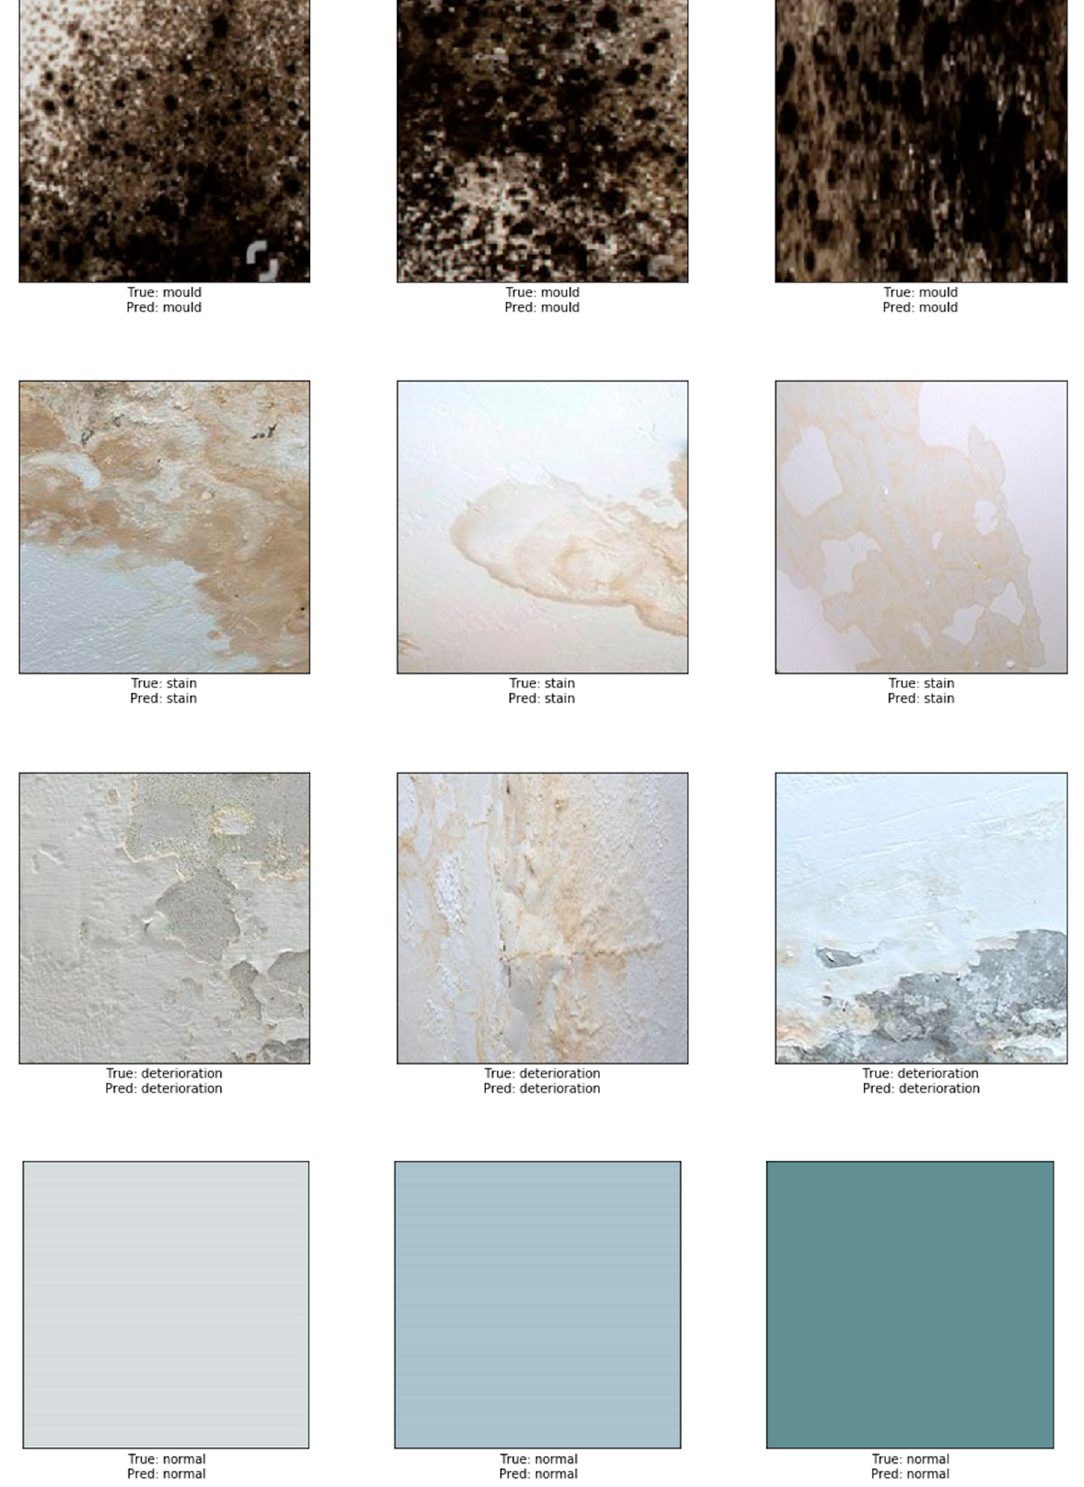
Figure 6. Correct classification of mould, stain and deterioration.